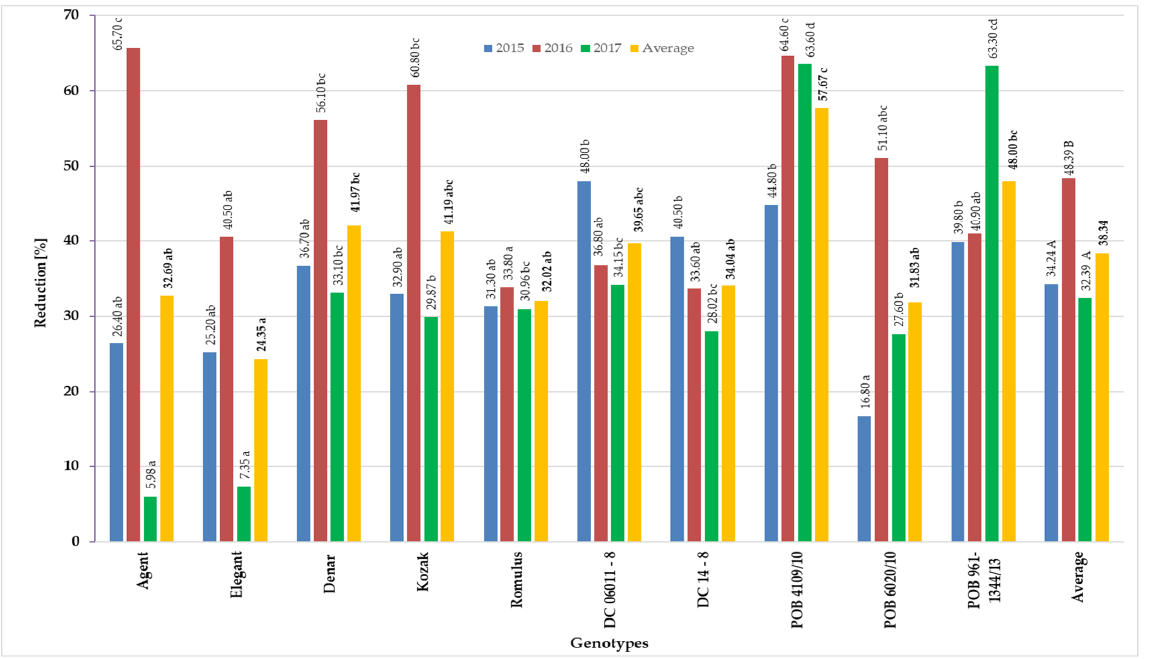
Figure 4. Kernels yield reduction after panicle inoculation with F. equiseti compared to control. The values obtained within an individual year for all genotypes, marked with the same letter do not differ significantly at p ≤ 0.05. The average values obtained for all genotypes over the three years of study (yellow columns), marked with the same letter, do not differ significantly at p ≤